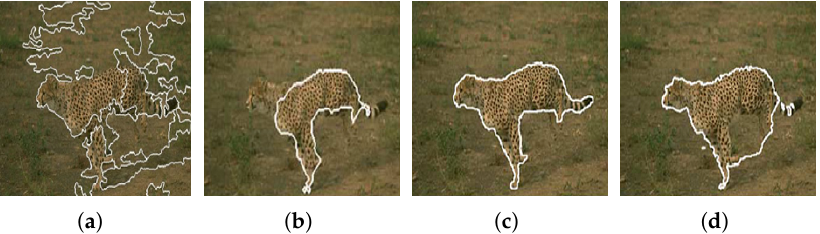
Figure 27. Results obtained using the algorithms proposed by ( a ) Deng and Manjunath [99]; ( b ) Chen et al. [101]; ( c ) Han et al. [102]; ( d ) Rother et al. [103]. Images referenced from Ilea and Whelan [105].